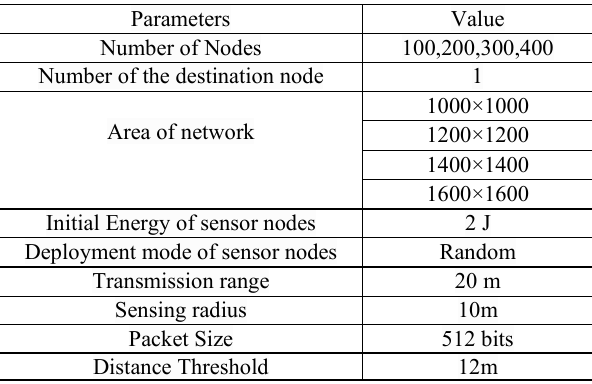
Table 4. Simulation Parameters for RL-LEACH